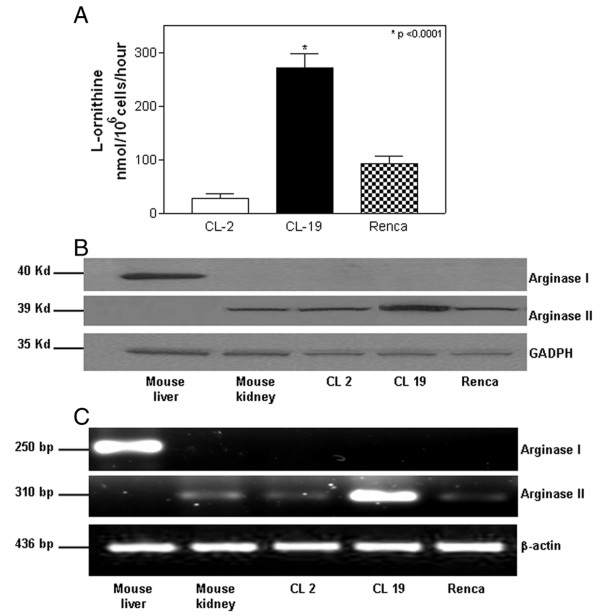
Arginase II expression in mRCC cell lines. (A) After 48 hours in culture, CL-19 cells presented significantly more arginase activity (*P < 0.0001) than did either CL-2 or Renca cells. Similar results were found after 72 hours in culture. (B) Twenty five micrograms of protein were tested for arginase I and arginase II expression by Western blot analysis. Normal mouse liver and kidney were used as positive controls for arginase I and arginase II respectively, whereas GAPDH was used as house keeping protein. (C) Total RNA from CL-2, CL-19 and Renca cells were obtained by TRIzol extraction and 1 μg of RNA was tested for arginase I, arginase II, and β-actin by RT-PCR. DNA fragment sizes generated by RT-PCR: arginase I, 250 bp; arginase II, 310 bp; and β-actin, 436 bp. These data are from a single experiment that is representative of five separate experiments.